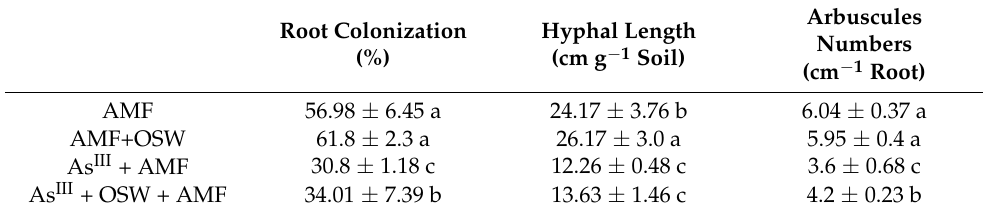
Table 1. Root colonization, hyphal length, and No. of arbuscules of wheat plants in the different treatments (AMF, and/or As III treatments). Three biological replicates per treatment are analyzed. Values are presented as mean ± SE. Means sharing the same letters, for a parameter within a species, do not differ significantly at p ≤